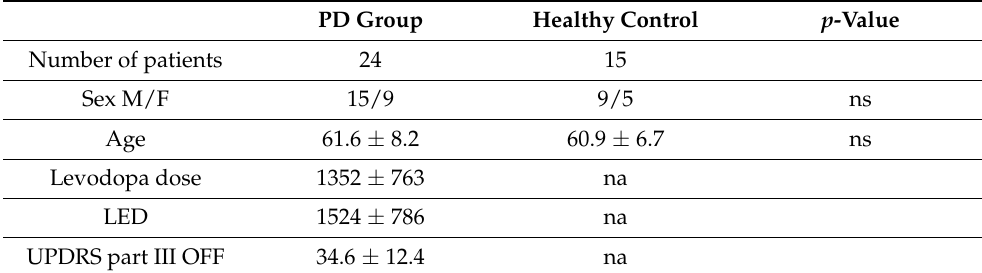
Table 1. Clinical characteristic of study groups. LED: levodopa equivalent dose; UPDRS: Unified Parkinson’s Disease Rating Scale; ns: non- significant; na: non